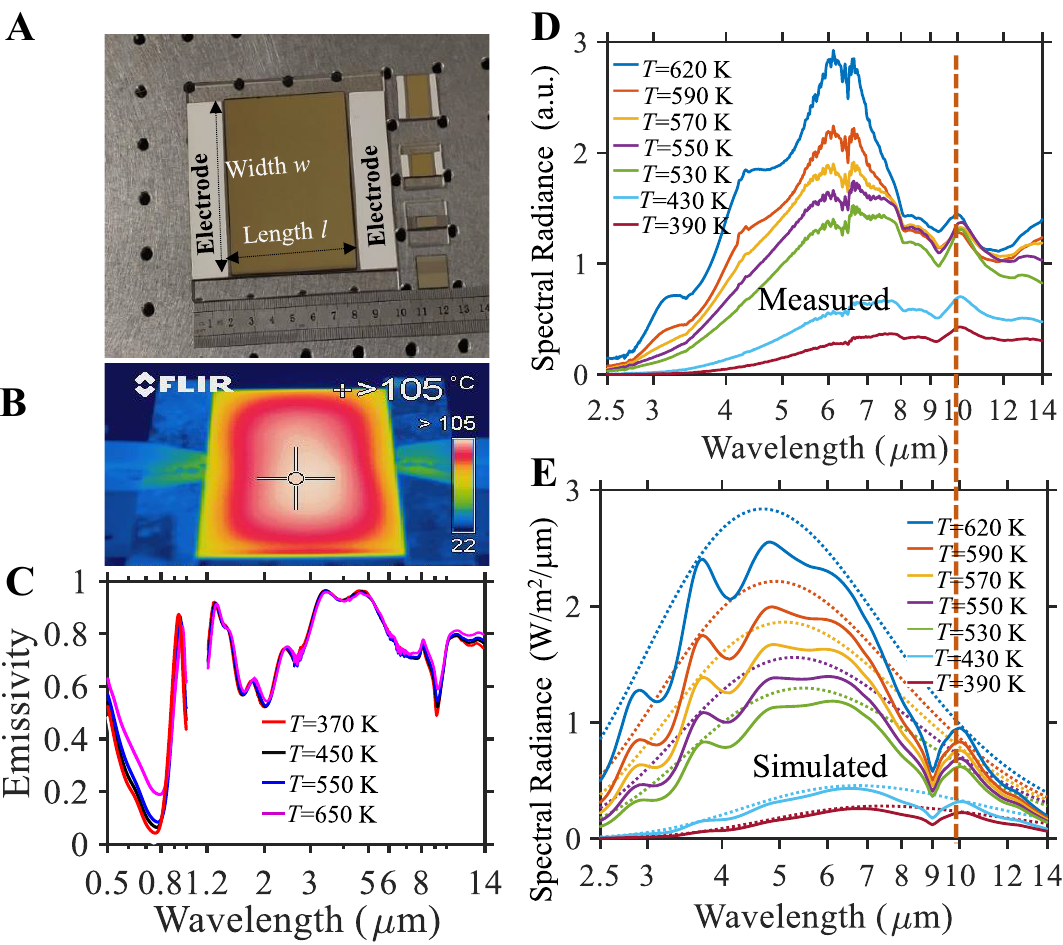
Figure 3: The optical emissivity and thermal radiation of the LTEs at elevated temperature. (A) A photograph of the fabricated LTEs with different width w and length l . (B) The thermal distribution of the samples taken by an infrared camera. (C) The measured emissivity at the angle of θ = 45 ° under different structure temperature obtained by controlling the voltage applied to the Ni 80 Cr 20 layer. (D) The measured spectral radiation intensity versus the device temperature by directing the radiated light into a parabolic mirror to be collimated into a FTIR for detection. (E) The calculated spectra radiance (solid lines) compared to that of an idea blackbody(dottedlines)atthesameoperatingtemperature.Thecalculationsareperformedbyintegratingtheemittedlightwithindivergence angleof5 ° fromthenormaloftheLTEs(seeEquationS2inSupplementarymaterial).Boththemeasuredandcalculatedspectrashowapeakat ∼ 10 μ m(markedbytheverticaldashedline)duetostrongemissivityatthiswavelength(seetheverticaldashedlineinFigure2C).Thestructure geometries are the same as those in Figure